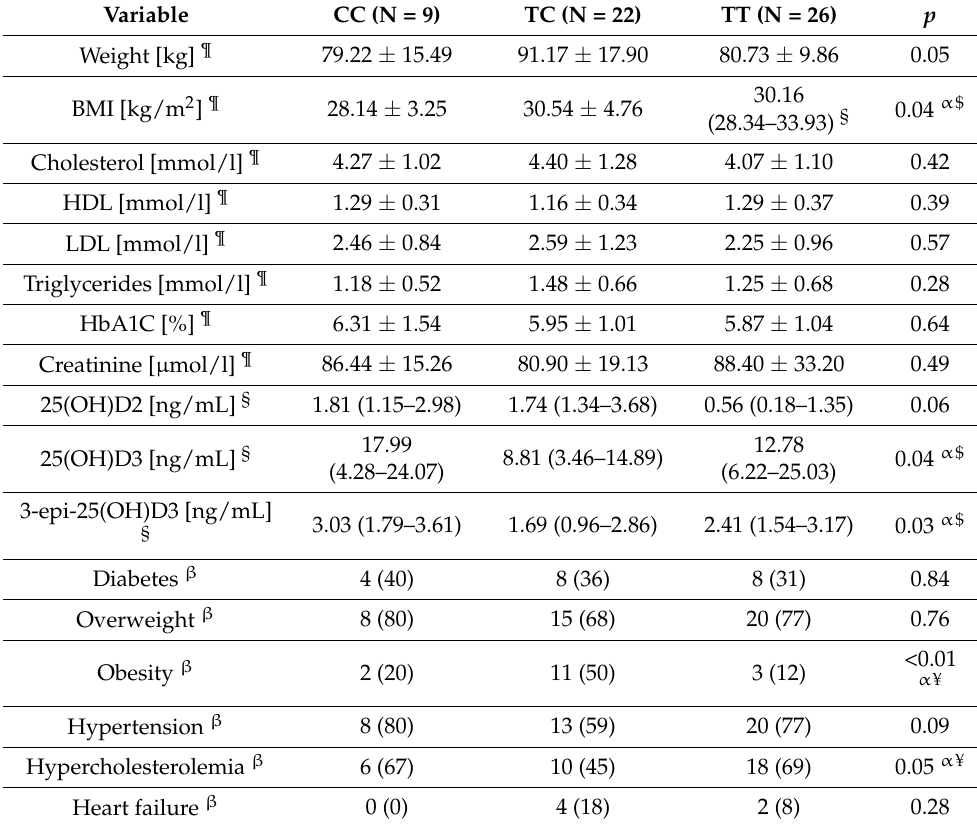
Table 4. Patient characteristics according to the TaqI